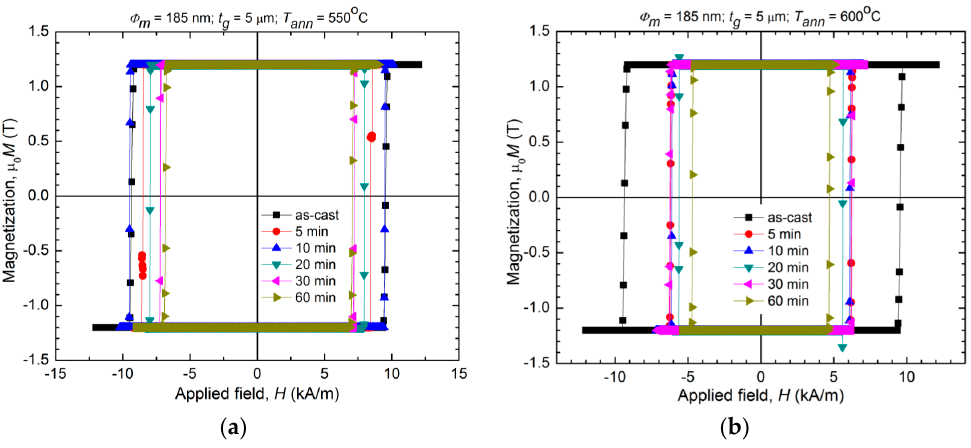
Figure 5. Axial hysteresis loops of a glass-coated Fe 73.5 Cu 1 Nb 3 Si 13.5 B 9 nanowire with the metallic nucleus diameter of 185 nm and the glass coating thickness of 5 μ m, with the annealing time as a parameter: ( a ) for an annealing temperature of 550 °C; and ( b ) for the annealing temperature of 600 °C.